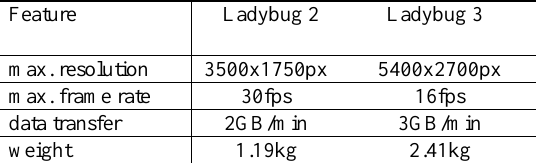
Table 1 Differences between two spherical video